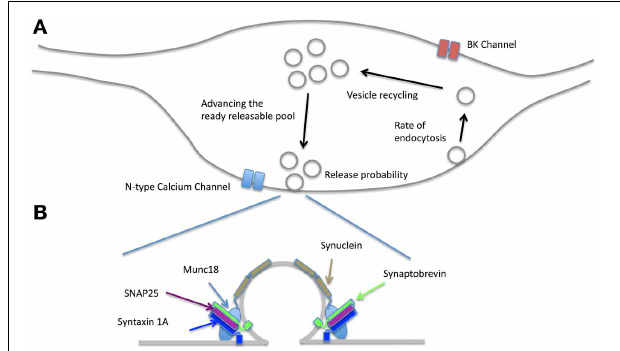
FIGURE 5 | Effects of NO on the pre-synaptic terminal. (A) NO affects release-probability most likely through a combination of effects including enhancing N-type calcium channel conductance via PKG, increasing the rate of endocytosis and vesicle recycling as well as altering the balance of the readily releasable pool via PKG and PIP 2 . By acting on BK channels, the probability of action potential failures during moderate spike rates is reduced (see text for the related references). (B) There is evidence that many of the SNARE proteins are affected by NO. Syntaxin 1A and SNAP25 can have nitrosothiol groups added although whether this happens at physiological NO concentrations is yet to be established. NO also creates nitrosothiol groups on Munc18 and thereby disinhibits syntaxin from forming the SNARE complex. Alpha Synuclein is also affected by NO signaling. Synaptobrevin is not known to be affected by